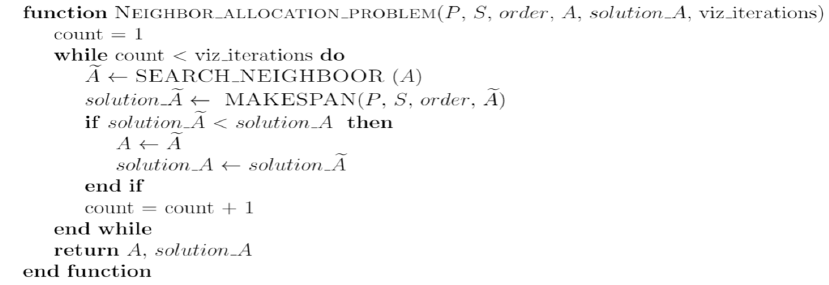
Fig. 6. Basis of Local Search - Allocation subproblem